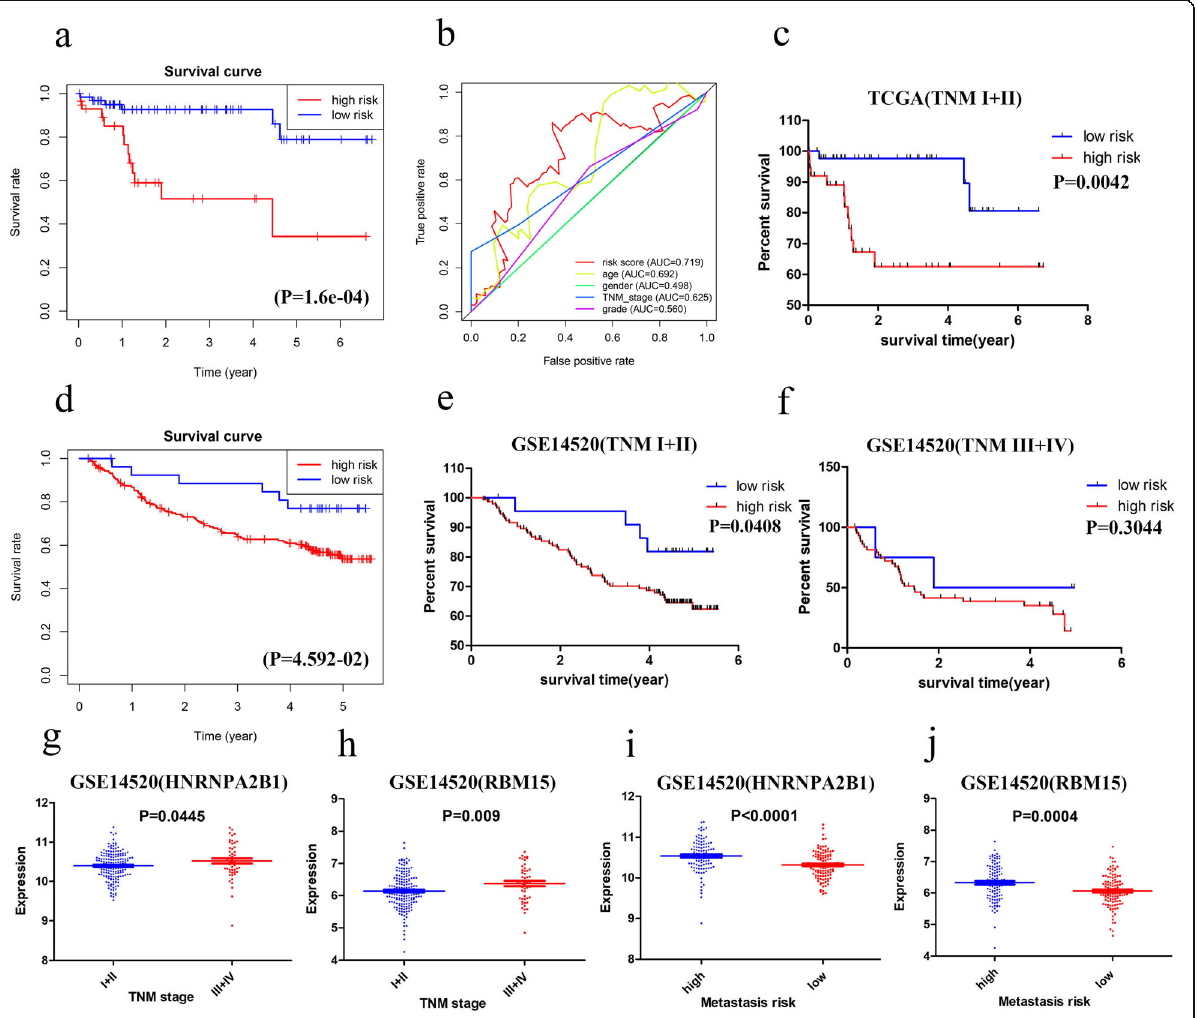
Fig. 2 Kaplan – Meier analysis of the high-risk and low-risk groups in HBV-related HCC in the TCGA cohort ( a ). The ROC curves of the risk score, age, gender, TNM stage and grade in HBV-related HCC ( b ). Kaplan – Meier analysis of the two groups (high-risk and low-risk) for patients with HBV- related HCC at early TNM stages ( c ). In the GSE14520 cohort, Kaplan – Meier analysis of the two groups (high-risk and low-risk) for patients with HBV-related HCC ( d ) and for patients at early TNM stages ( e ) and late TNM stages ( f ). Expression of HNRNPA2B1 and RBM1 based on the GSE14520 dataset ( g-j